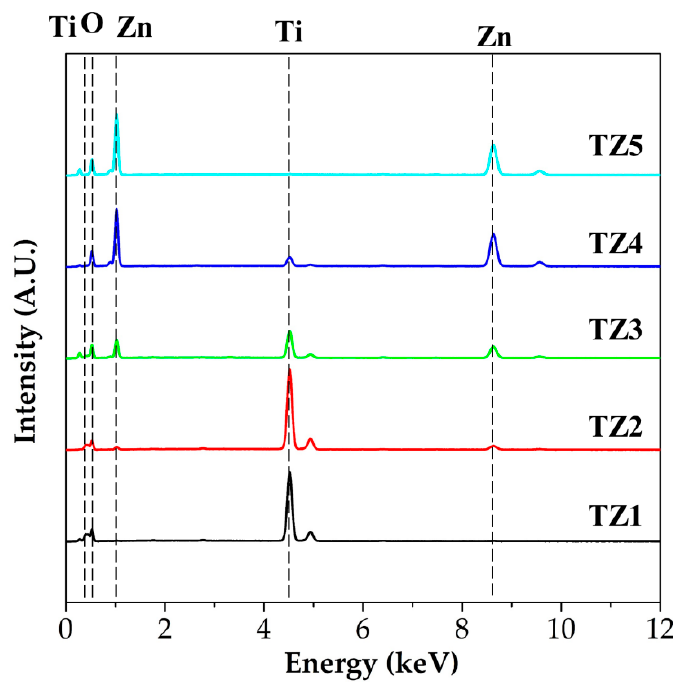
Figure 5. Energy-dispersive spectroscope (EDS) spectra with different molar ratios of Ti and Zn (TZ1: 10:0, TZ2: 9:1, TZ3: 5:5, TZ4: 1:9 and TZ5: 0:10). Table 2. Chemical composition in atomic percent of TZ1, TZ2, TZ3, TZ4 and TZ5. Sample Elements TZ1